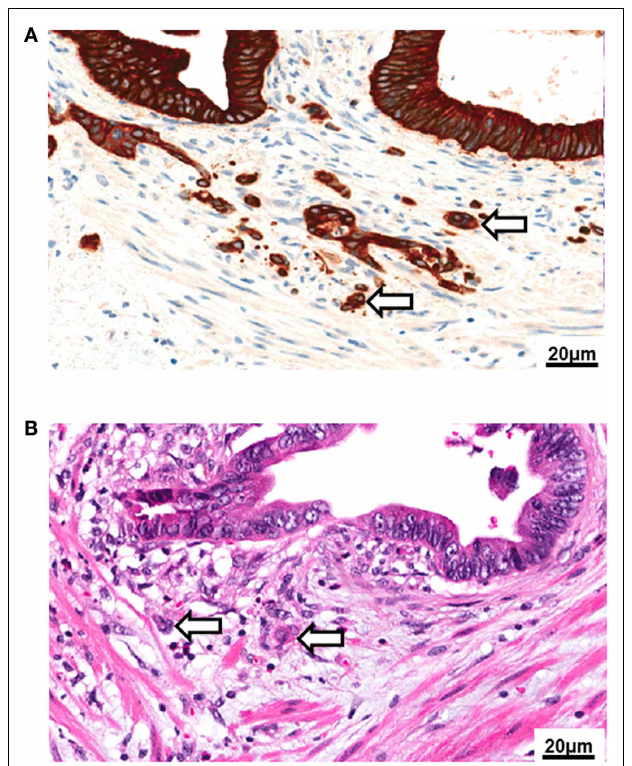
FIGURE 2 |Tumor budding leads to vascular invasion and metastasis . The formation of tumor buds is thought to be the visible correlate of epithelial–mesenchymal transition (EMT) in the tumor microenvironment. Following tumor cell dissociation, lymphovascular invasion is frequently observed in high-grade budding tumors.TB could be a source of circulating cancer cells (CICs), leading to the establishment of metastasis at distant sites in the process of mesenchymal–epithelial transition